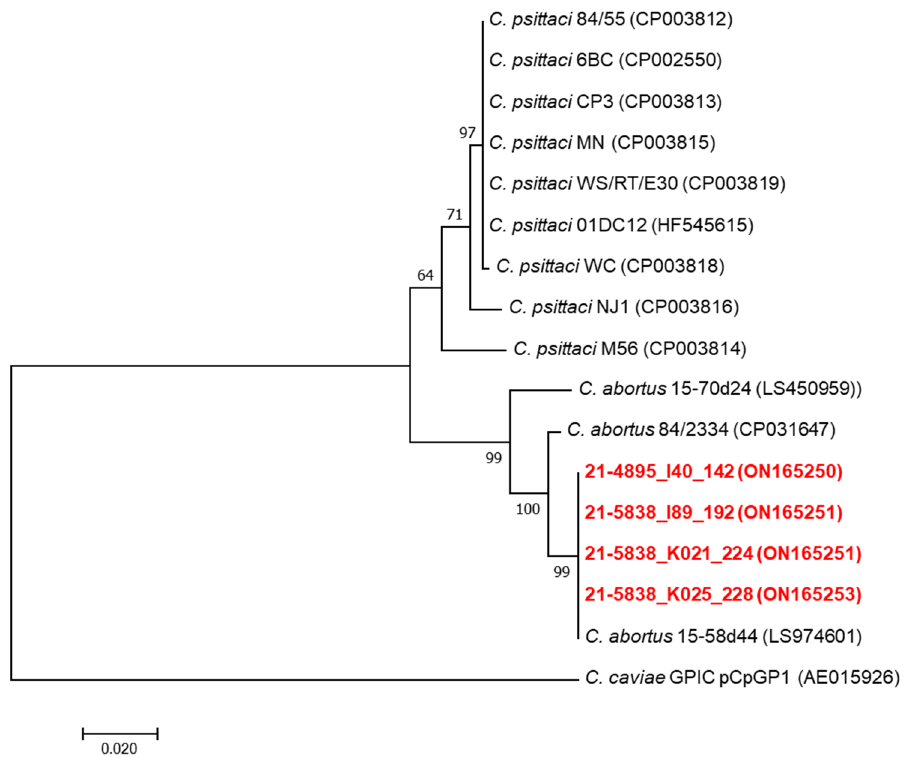
Figure 2. Phylogenetic analyses of plasmid XerC gene fragment sequences of Chlamydia. Nucleotide sequences (734 nucleotides) were aligned and analysed in MEGA7. Phylogenetic trees were constructed by using the maximum likelihood method based on the general time-reversible model. Bootstrap tests were for 1000 repetitions. Numbers on tree nodes indicate bootstrap values of the main branches. Horizontal line scale indicates the number of nucleotide substitutions per site. The outgroup is represented by C. caviae plasmid DNA fragment. Accession numbers of different Chlamydia are indicated. The red colour represents the avian C. abortus strains analysed in this study.